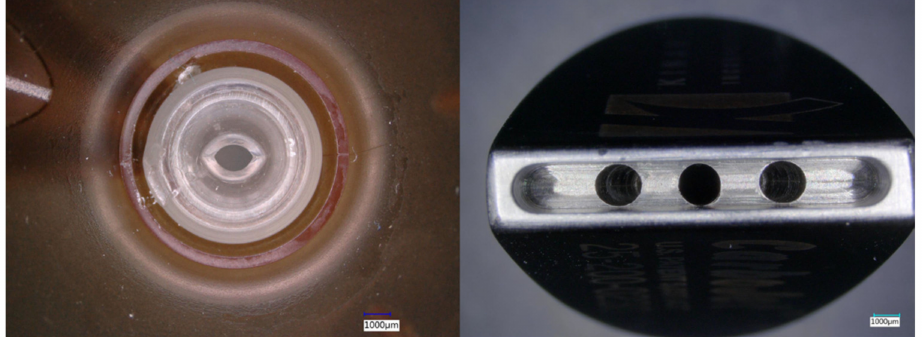
Figure 3. Top view of: ( left ) Stryker- InterPuls bone cleaning tip, ( right ) KINAMED—CarboJet Wide-Angle Knee—Nozzle.